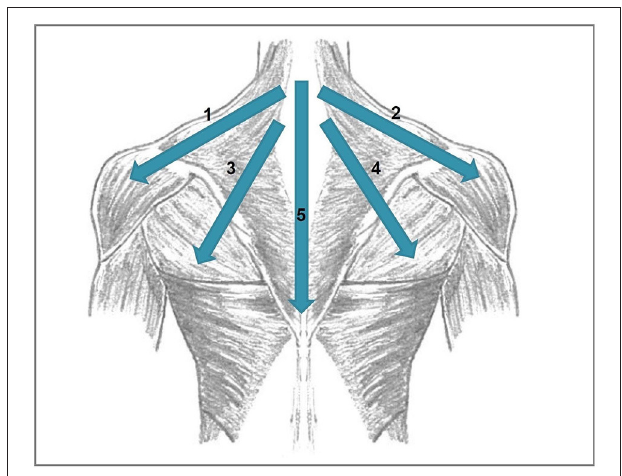
FIGURE 2 | Directions of the movements done during rPMS stimulation. 1, left trapezius and deltoid muscle; 2, right trapezius and deltoid muscle; 3, left trapezius and latissimus dorsi muscle, 4, right trapezius and latissimus dorsi muscle; 5, cranio-caudal movement over the backbone.